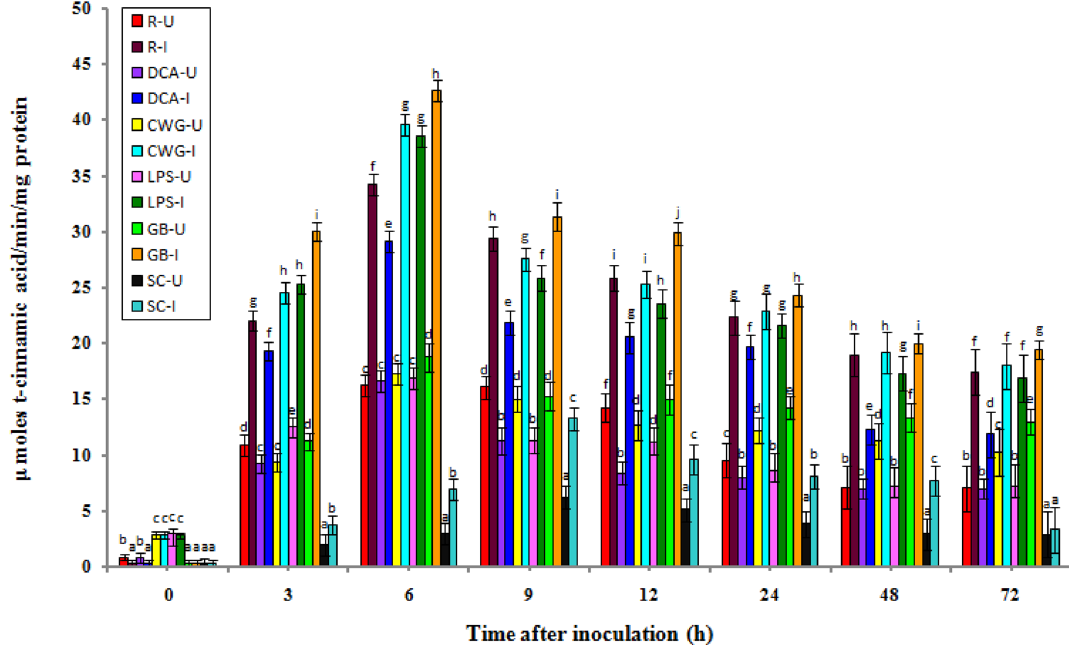
Figure 1. Temporal pattern of PAL activity in 2-day old P. glaucum seedlings with (I-inoculated) or without (U-uninoculated) Sclerospora graminicola inoculation. R—resistant, S—susceptible, DCA—3,5- Dichloroanthranilic acid treated, CWG—Cell Wall Glucans isolated from the endophyte Trichoderma hamatum UOM 13, LPS—Lipopolysaccharides isolated from bacteria Pseudomonas fluorescens UOM 14, GB-Glycinebetaine an amino acid derivative. Bars indicate standard errors; means with different superscripts are significantly different, as shown by Tukey’s HSD test ( p ≤ 0.05).